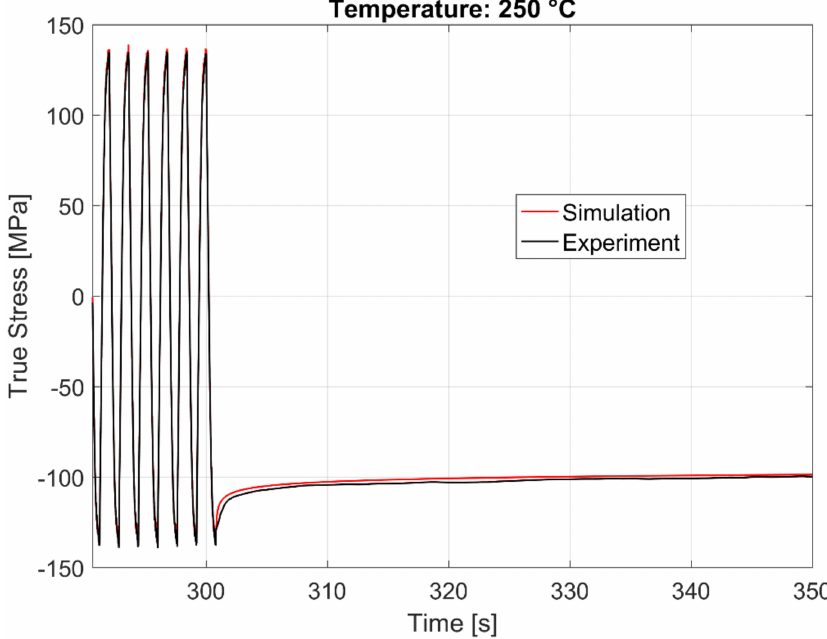
Figure 24. Time history of the experimental vs. visco-plastic model prediction at 250 ◦ C.